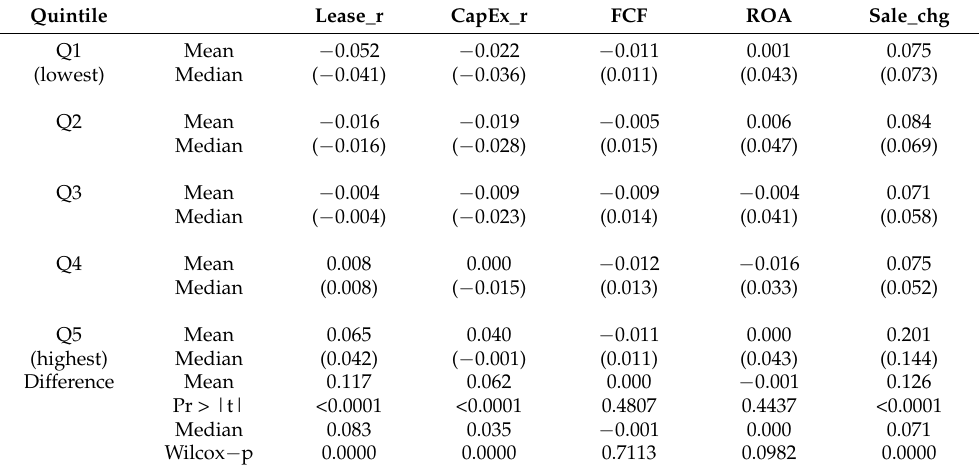
Table 4. Unexpected Investments in Leases and Capital Expenditures, and Free Cash Flows Descrip- tive Statistics by Lease Residual